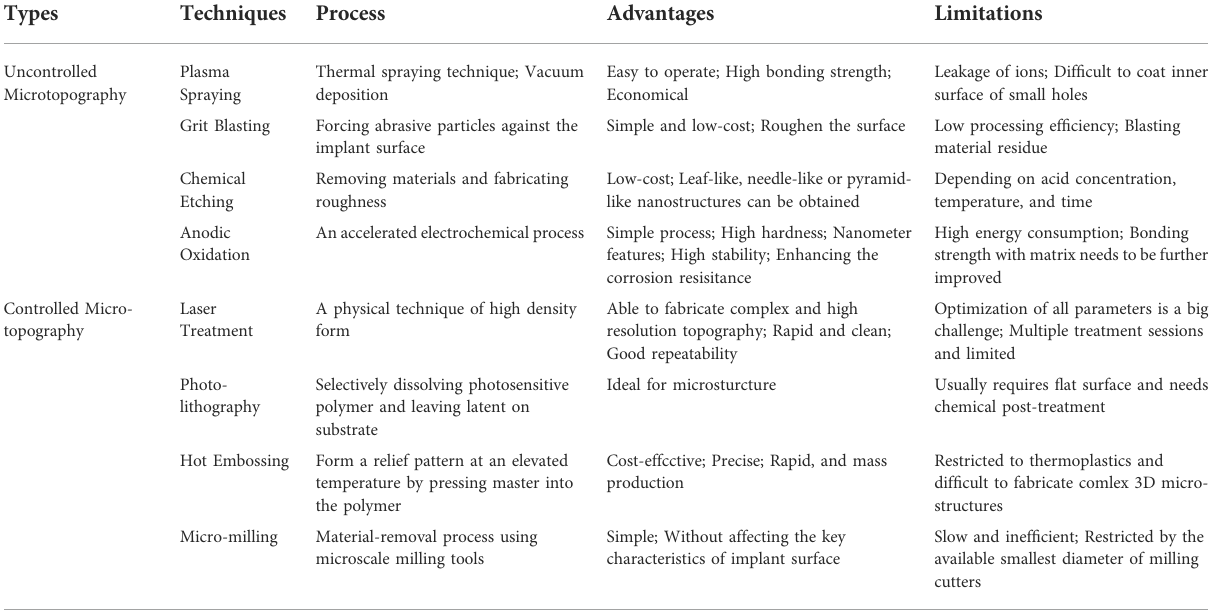
TABLE 1 Characteristics of the surface modi fi cation techniques for